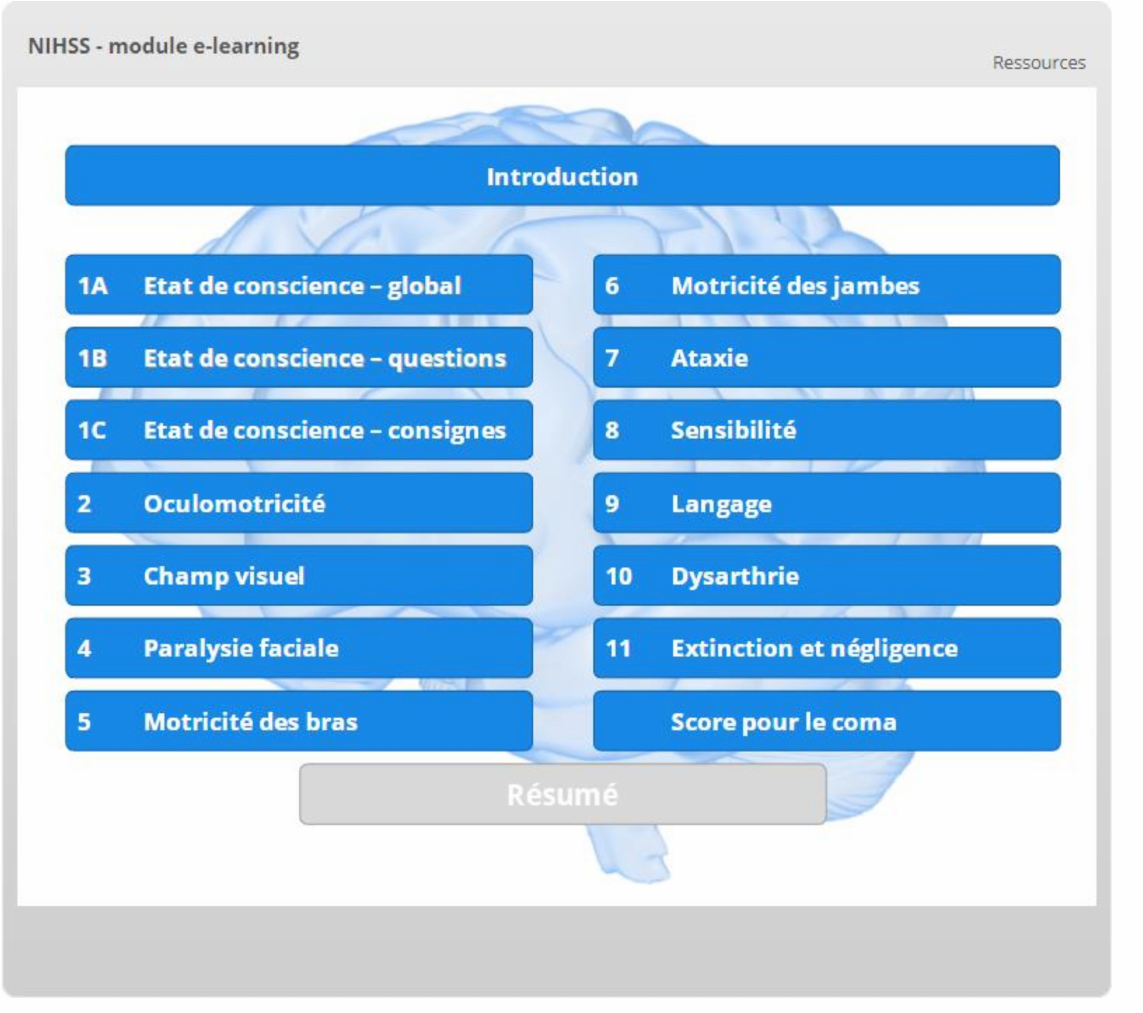
Figure 2. Table of contents of the interactive e-learning